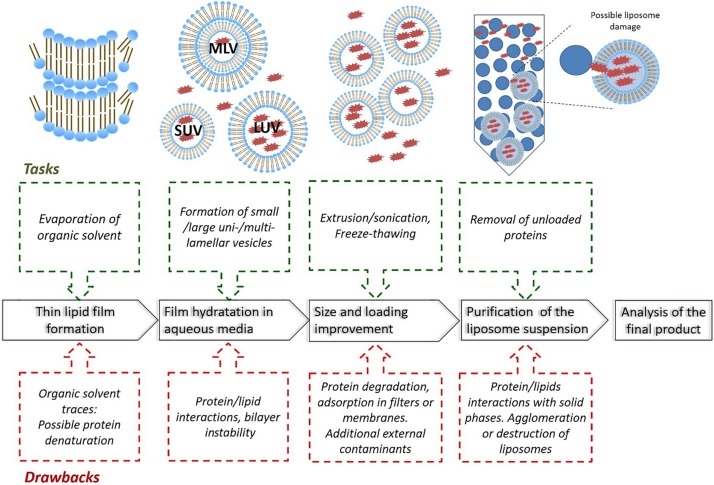
Main steps involved with the preparation of protein-loaded liposomes, including typical tasks and drawbacks (MLV: Multilamellar Vesicles, LUV: Large unilamellar vesicles, SUV: small unilamellar vesicles).